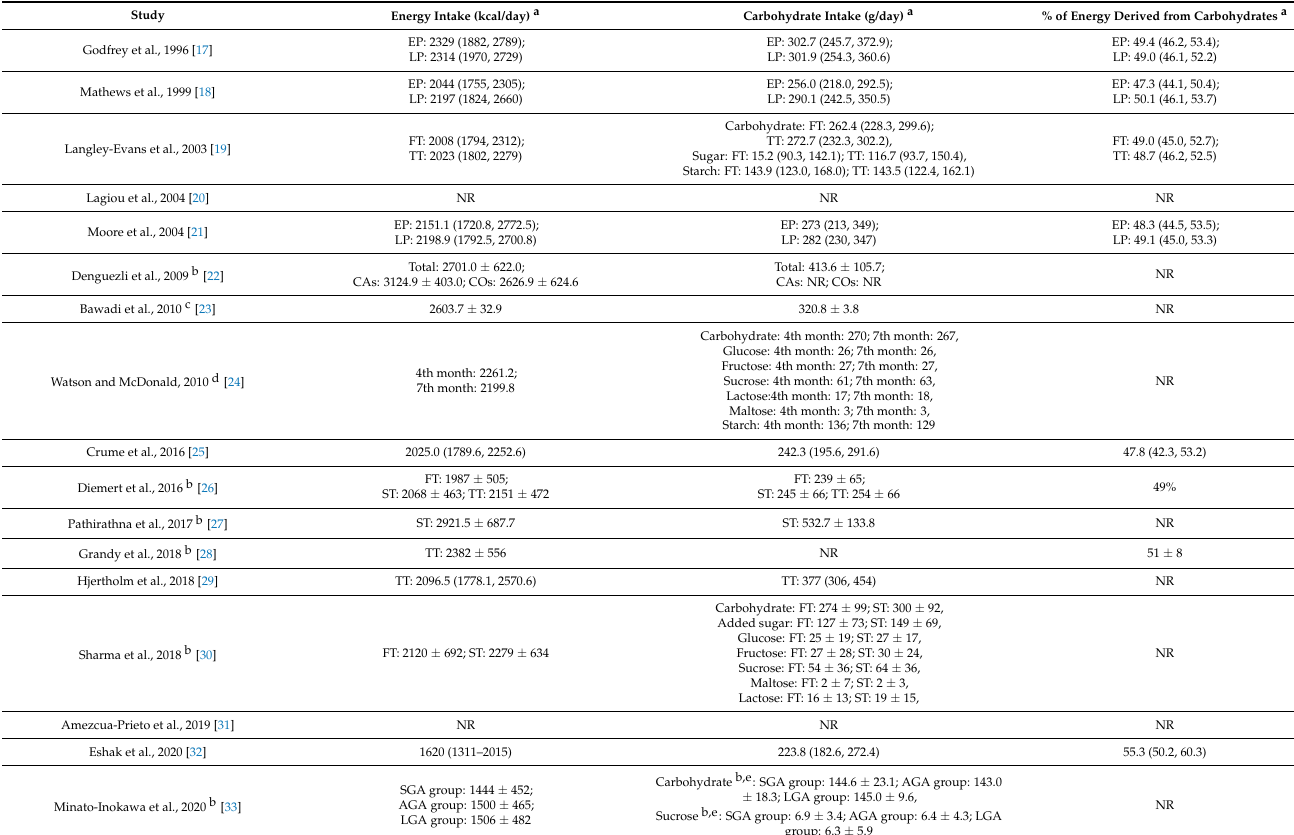
Table 1. Energy and carbohydrate consumption among pregnant